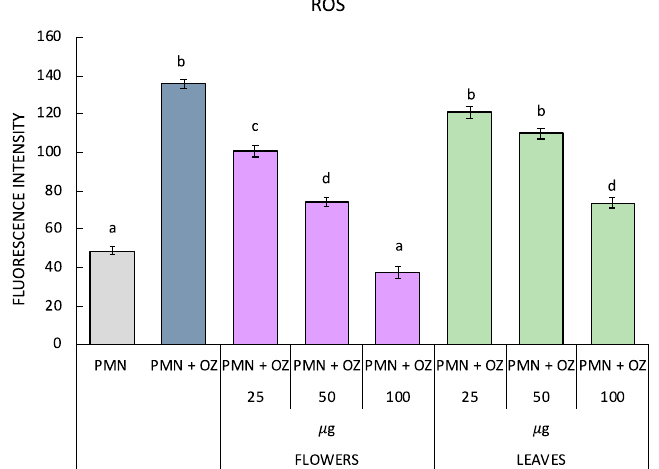
Figure 3. ROS production in polymorphonuclear cells treated with essential oils of P. ferulacea at concentrations of 0, 25, 50, 100 µ g/mL with or without OZ (0.5 mg mL − 1 ). Data were presented as mean and standard error and they were analyzed with a paired t -test. Bars not accompanied by the same letter were significantly different at p < 0.05.